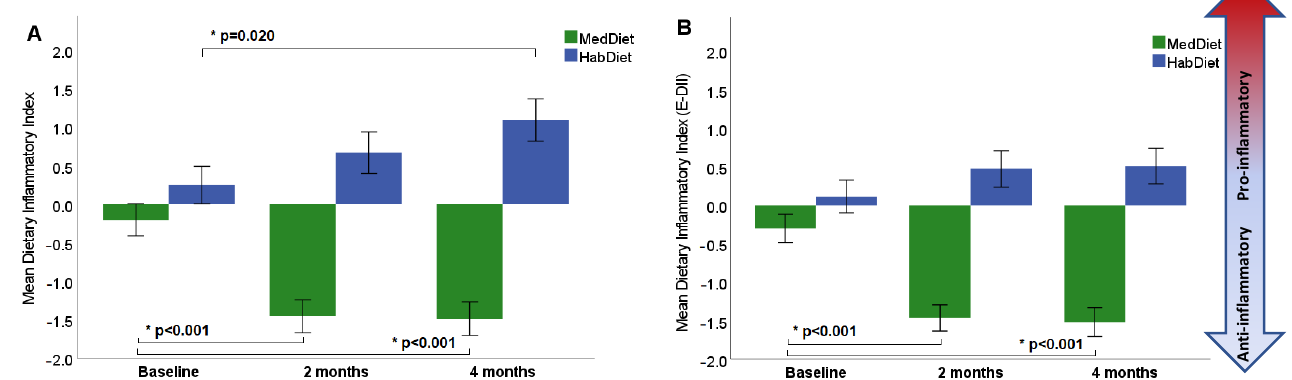
Figure 1. Changes in the dietary inflammatory index during the MedLey intervention: ( A ) raw model of dietary inflammatory index; ( B ) E-DII (dietary inflammatory index adjusted for energy). DII was calculated at 2 and 4 months of the intervention period. A more negative DII score indicates a more anti-inflammatory diet, while a more positive score indicates a more pro-inflammatory diet; * p values represent statistical significance determine by LMEM. MedDiet, Mediterranean diet; HabDiet, habitual diet.